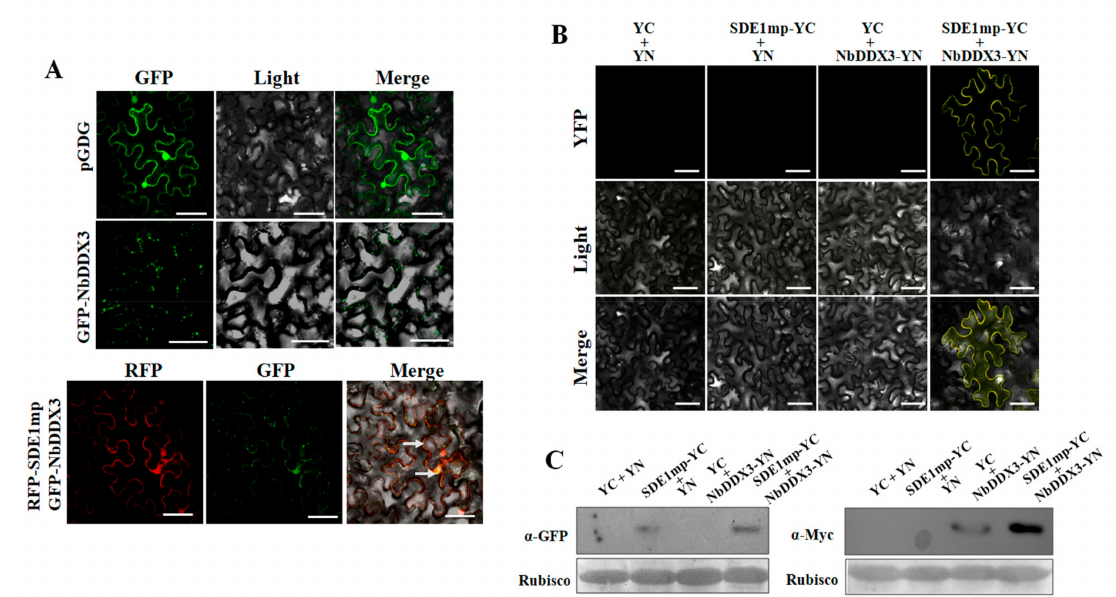
Figure 3. Subcellular localization of NbDDX3 and its interaction with SDE1mp in N. benthamiana cells. ( A ) Subcellular localization and co-localization of RFP-SDE1mp and GFP-NbDDX3 on the cell membrane at 2 dpi. ( B ) Bimolecular fluorescence complementation analysis showing the spatial interaction of SDE1mp and NbDDX3. The bar represents 50 µ m. ( C ) Infiltrated plant leaves were collected for immunoblotting assays with anti-GFP and anti-Myc antibodies for evaluation of protein expression levels. Ponceau S staining indicates equal loading of proteins. Samples were examined under the microscope at 2 dpi. All experiments were repeated three times.